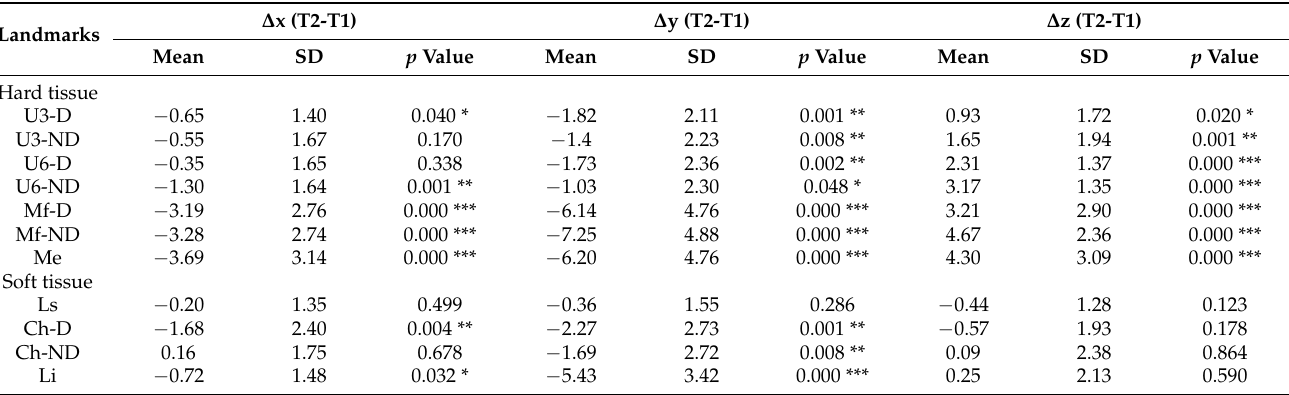
Table 3. Changes in hard and soft tissue landmarks on 3D CT and FS images between the T1 and T2 stages.